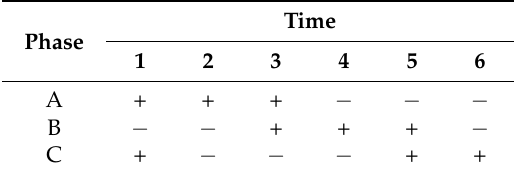
Figure 3. Current waveform supplied to three-phase windings. Table 4. Current directions of three-phase winding coils versus time.